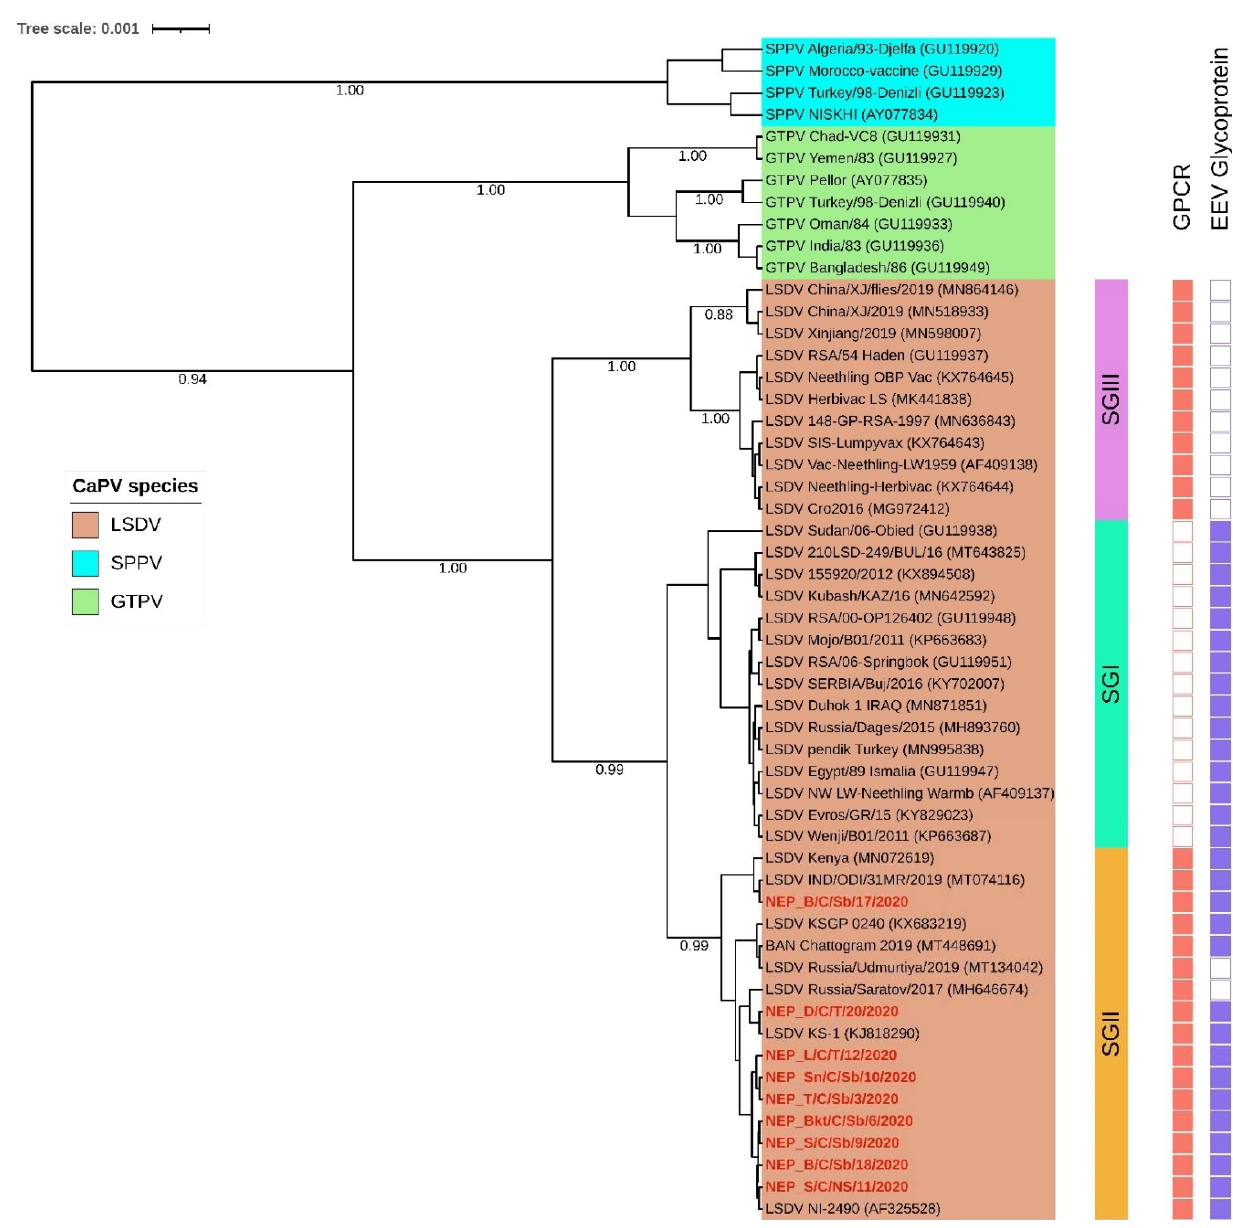
Figure 4. Maximum clade credibility (MCC) tree based on the complete RPO30 gene sequences of CaPVs with LSDVs from Nepal (in red) visualized on iTOL, together with isolates clustering based on the presence (filled box) or absence (empty box) of sequence insertion in the GPCR and the EEV glycoprotein genes.